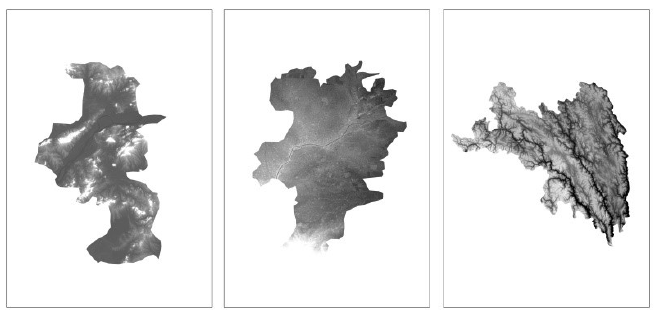
Figure 8. DEMs of Nanjing, Dongying, and Changdu.